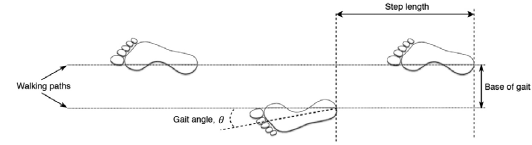
Figure 3. Walking path